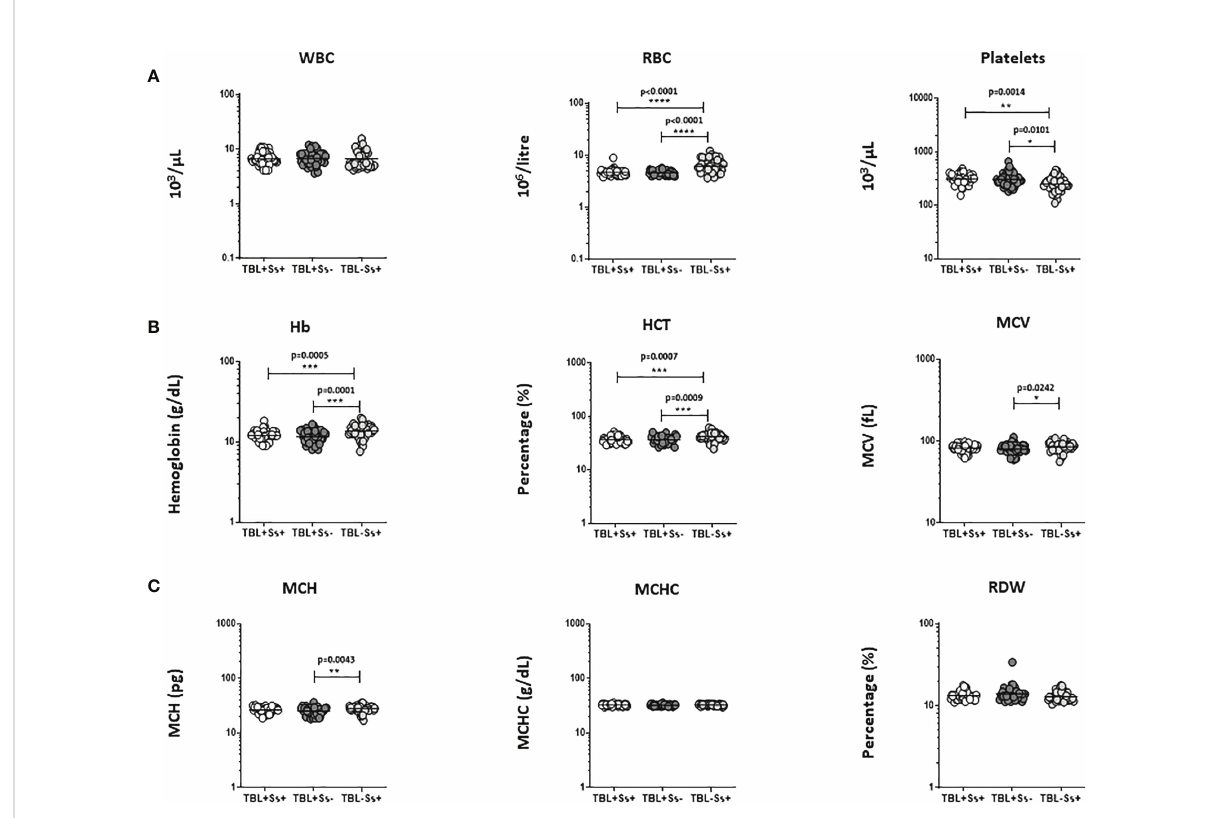
FIGURE 1 Altered hematological parameters of the population. We have analyzed different hematological (A) WBC, RBC, platelets (B) Hb, HCT, MCV (C) MCH, MCHC, RDW) parameters in TBL+Ss+ (n=44), TBL+Ss- (n=44) and TBL-Ss+ (n=44) groups using the AcT5 Diff hematology analyzer (Beckman Coulter). We used Kruskal-Walli ’ s test with Dunn ’ s multiple comparisons to measure the statistical P values. The signi fi cance of p values was represented as '*' p<0.05, '**' p<0.01, '***' p<0.001, '****'